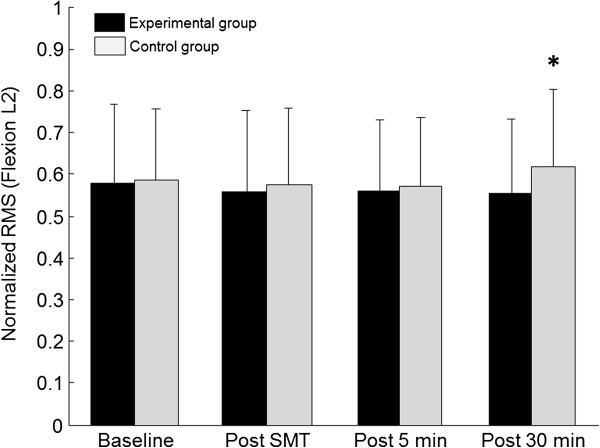
Mean baseline and post spinal manipulation L2 paraspinal normalized RMS values (EMG) for both the control and experimental groups during the flexion phase of the task. *RMS values in the control group significantly increased during the last block of trials. Whiskers indicate standard deviation.